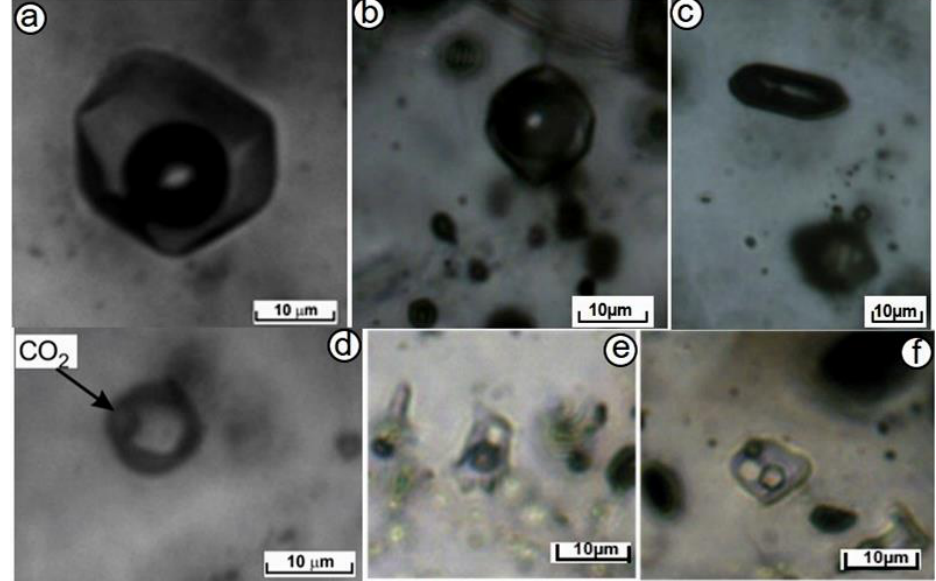
Figure 12. Fluid inclusion types distinguished according to the phases present at room temperature.